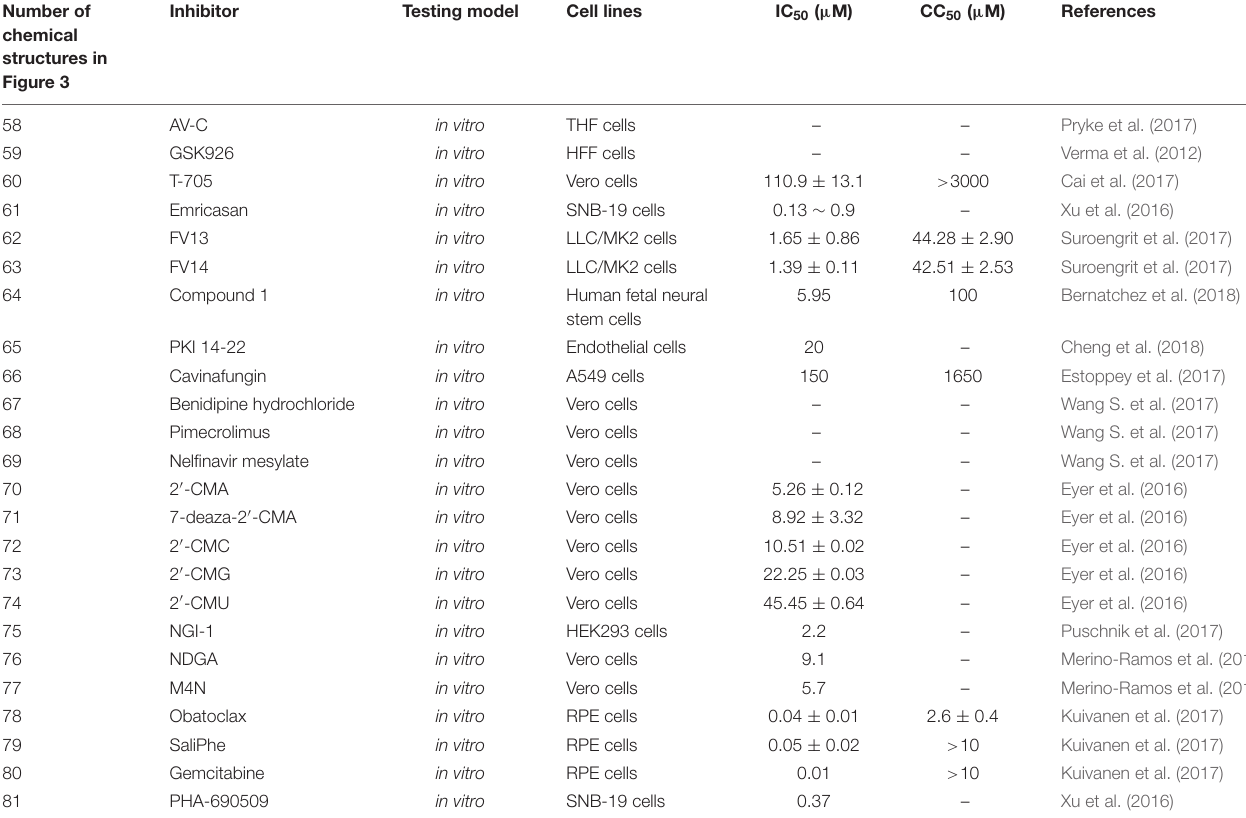
TABLE 4 | Other small-molecule inhibitors with undefined mechanisms. Number of chemical structures in Figure